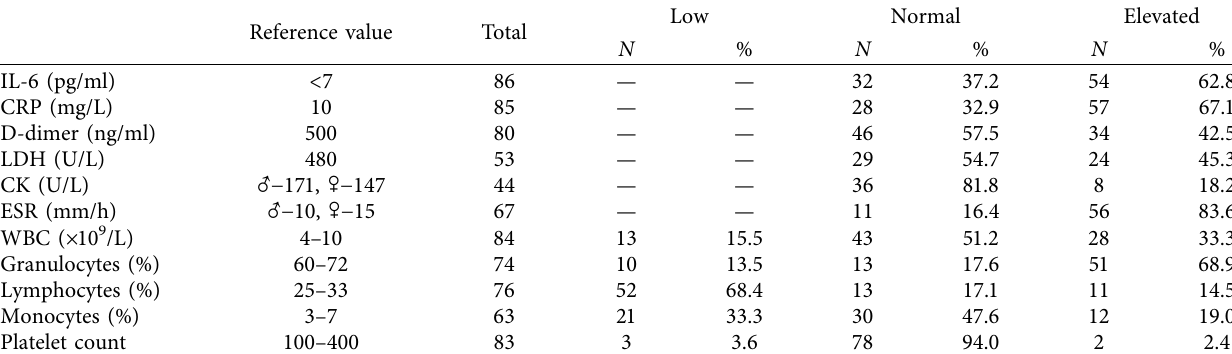
Table 3: Frequencies of biochemical and hematological parameters in the whole group of